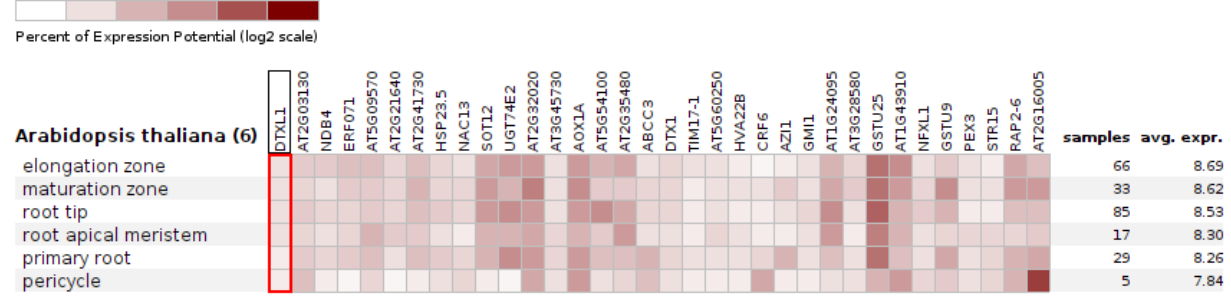
Figure 13. Root-tissue-specific expression pattern of the common set of genes ( n = 34) that were differentially expressed in the transcriptome of ailanthone-treated Col-0, Cvi-0, and U112-3 samples analyzed by using the Genevestigator database (accessed on 1 May 2021) (https://genevestiga-